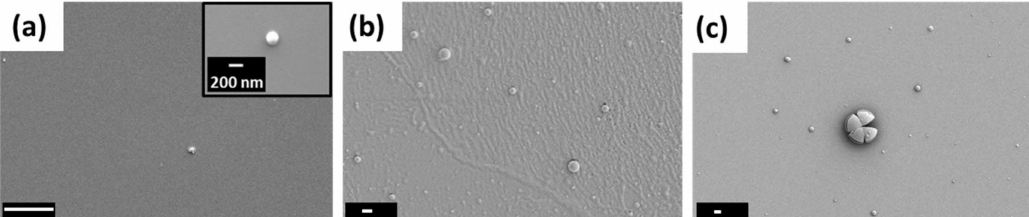
Figure 5. FE-SEM images of the PGMA- b -Ru(bpy) 3 - b -PHPMA triblock copolymer prepared in di ff erent water / methanol solutions: water ( a ), 70% methanol ( b ), and methanol ( c ). Scale bar = 2 µ m. The inset shows one micelle at higher